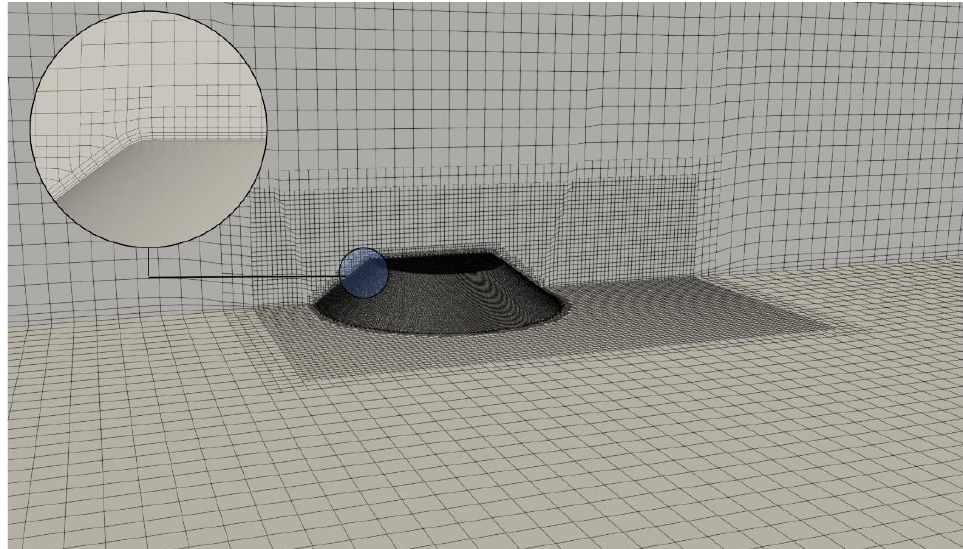
Figure 2. Computational grid for the validation case.